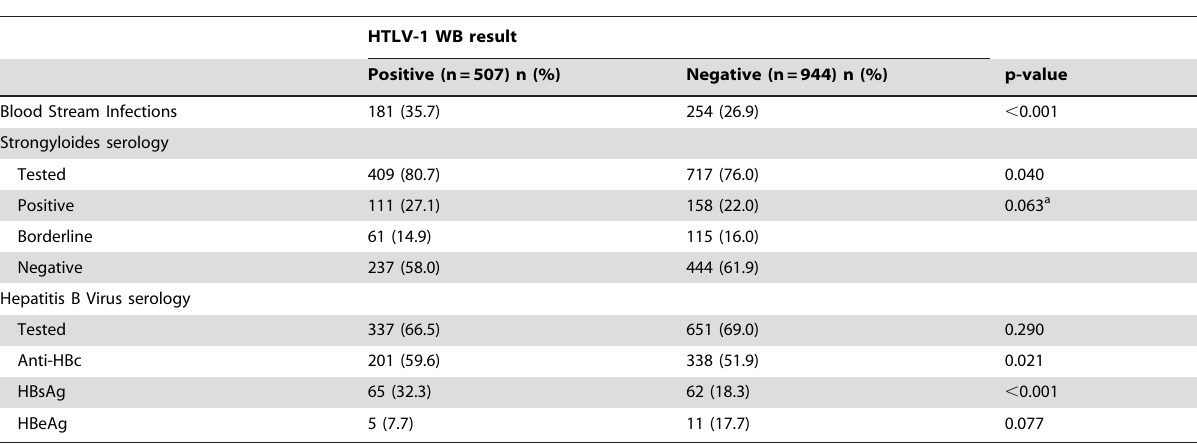
Table 6. Results of microbiological tests for 1451 Indigenous Adults admitted 2005–2010 a .